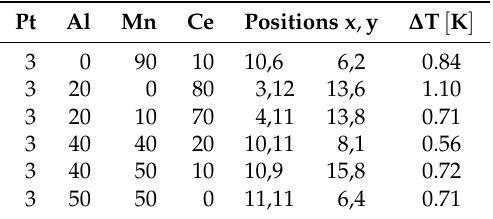
Table 1. Composition of most promising materials from composition spread library Pt 3 Al a Mn b Ce c on slate library plate 1, positions on slate library 1, and average ∆ T